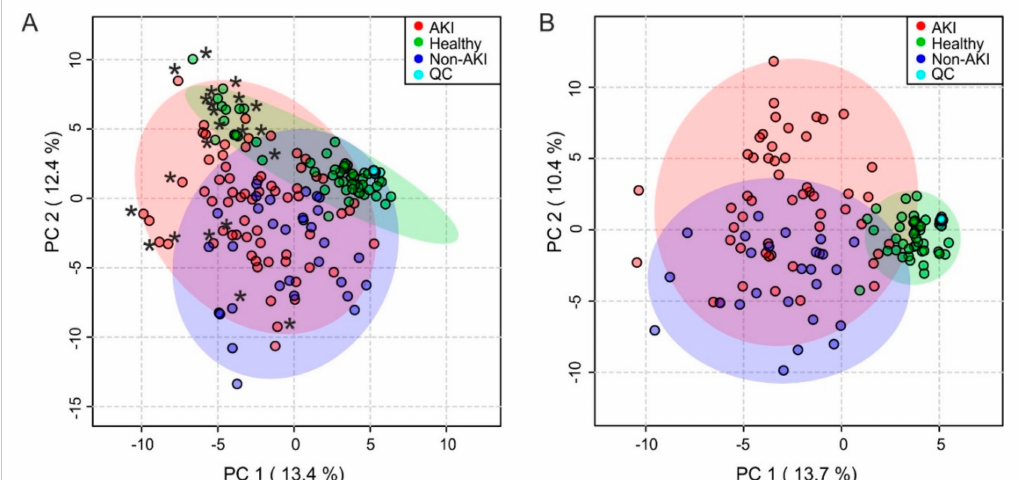
Figure 1. Principle component analysis of the urine spectral bucket table. Variable bucketing was employed leading to 129 buckets. Metabolites were assigned, whenever possible, based on comparison with database entries or literature and were confirmed by spiking experiments. ( A ) All spectra (AKI patients, n = 65; healthy controls, n = 53; non-AKI patients, n = 31; QC, n = 15), * denotes neonatal spectra, ( B ) neonatal spectra excluded (AKI patients, n = 53; healthy controls, n = 42; non-AKI patients, n = 25; QC, n = 15). Outliers were not detectable. AKI, acute kidney injury; QC, quality